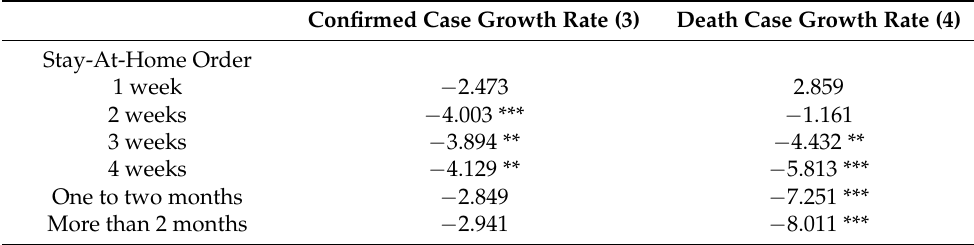
Table A2. The impact of policy on COVID-19 cases, and mortality of COVID-19 (7-day